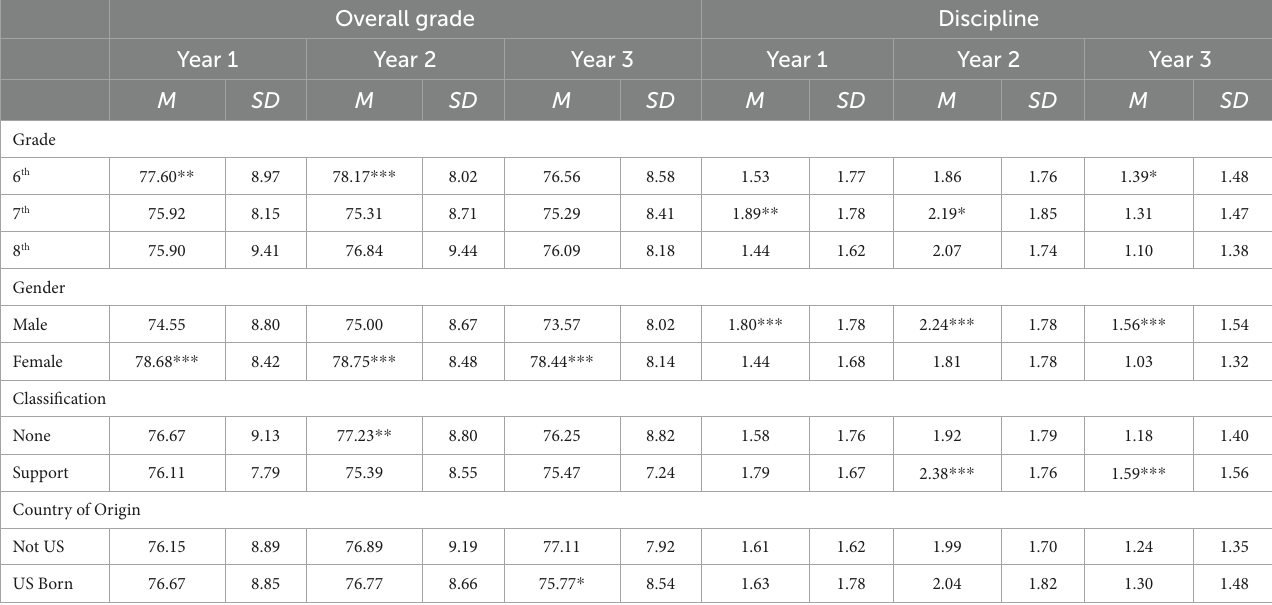
TABLE 7 Impact of demographic covariates on overall grade and